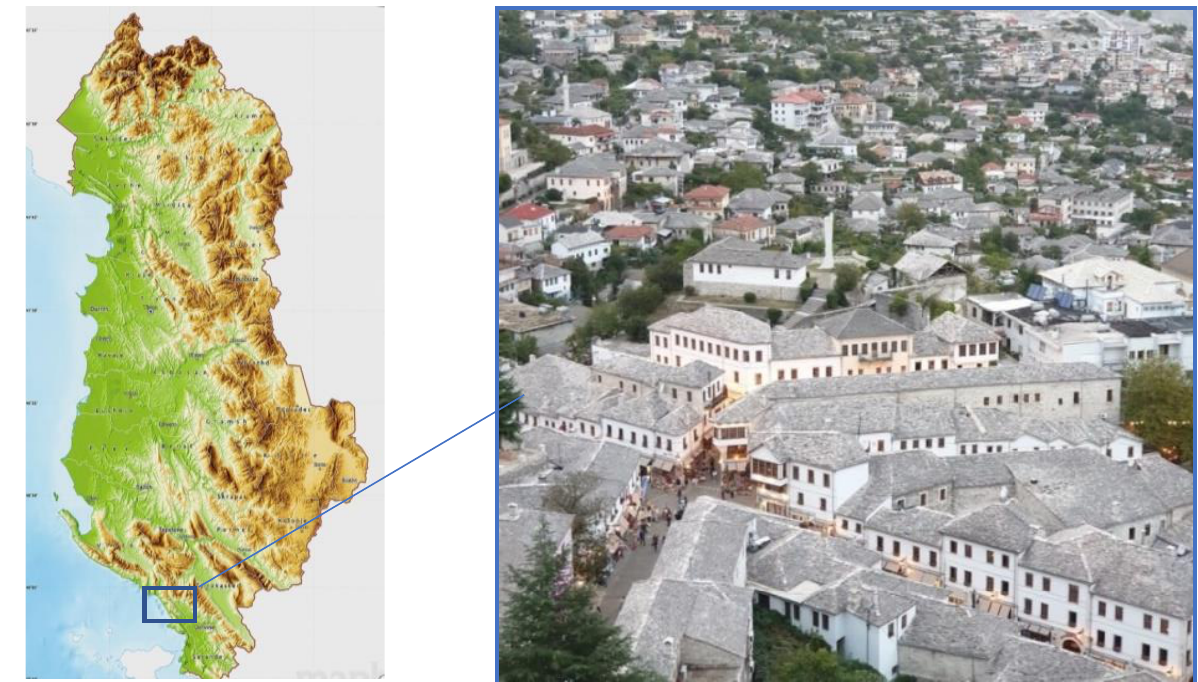
Figure 1. Location of the city ( left ) and aerial view of the old city center ( right ).